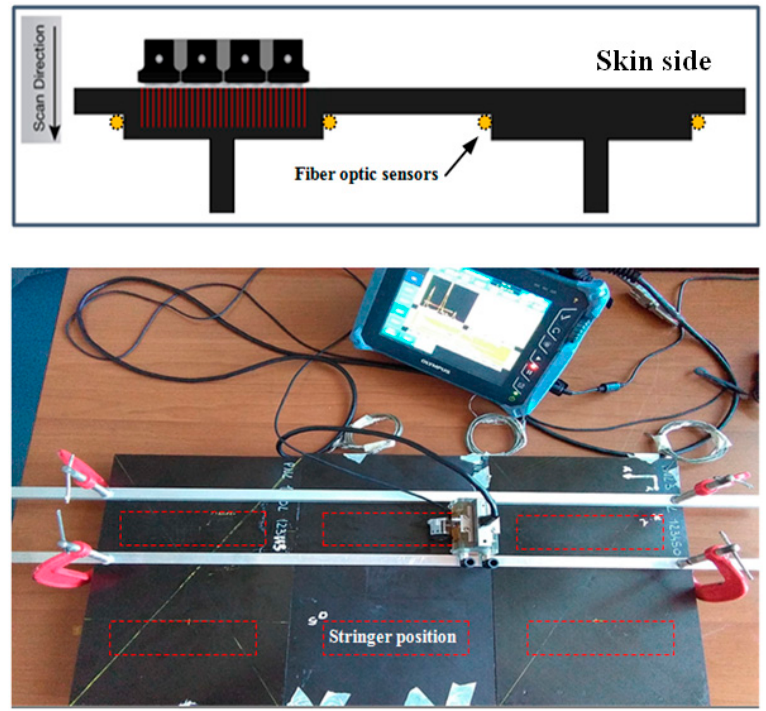
Figure 6. Scan pattern section view (upper) and scan setup (lower).